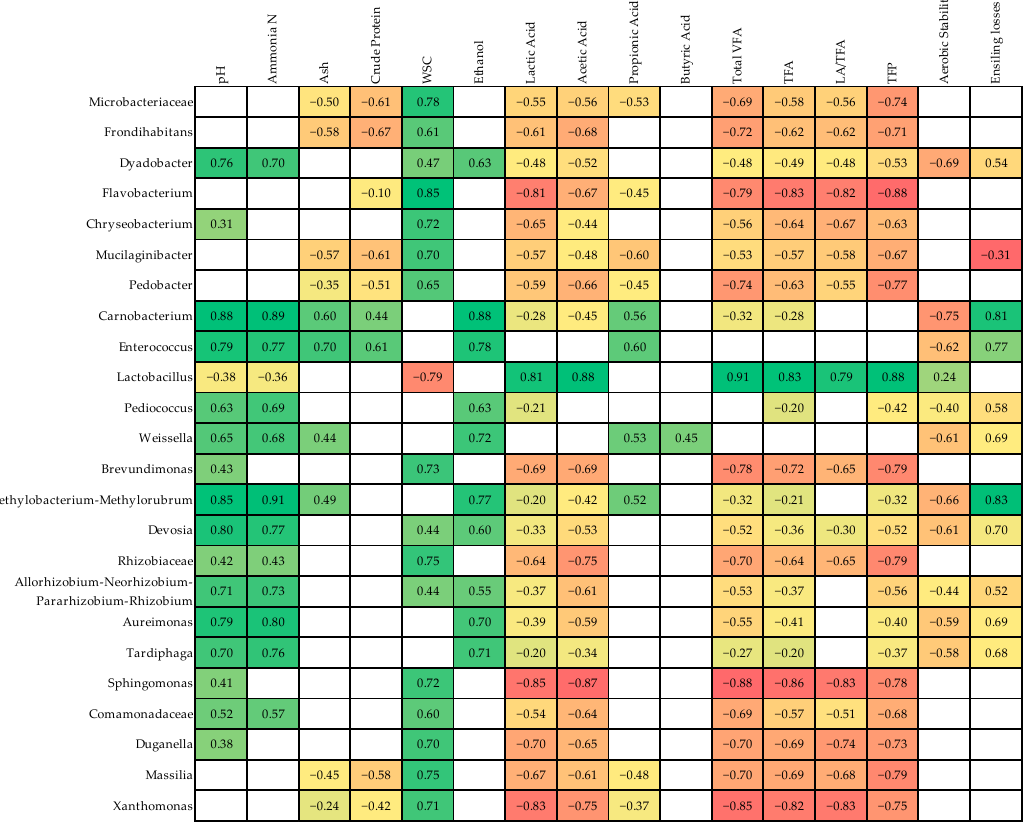
Figure 3. Spearman correlations between bacterial communities and silage parameters of grass silage with different additives. WSC: Water soluble carbohydrates, VFA: Volatile fatty acids, TFA: Total fermentation acids, LA: Lactic acid, TFP: Total fermentation products. From green (strong and positive correlation) to red color (strong and negative correlation), while empty cells indicate not significant correlation.